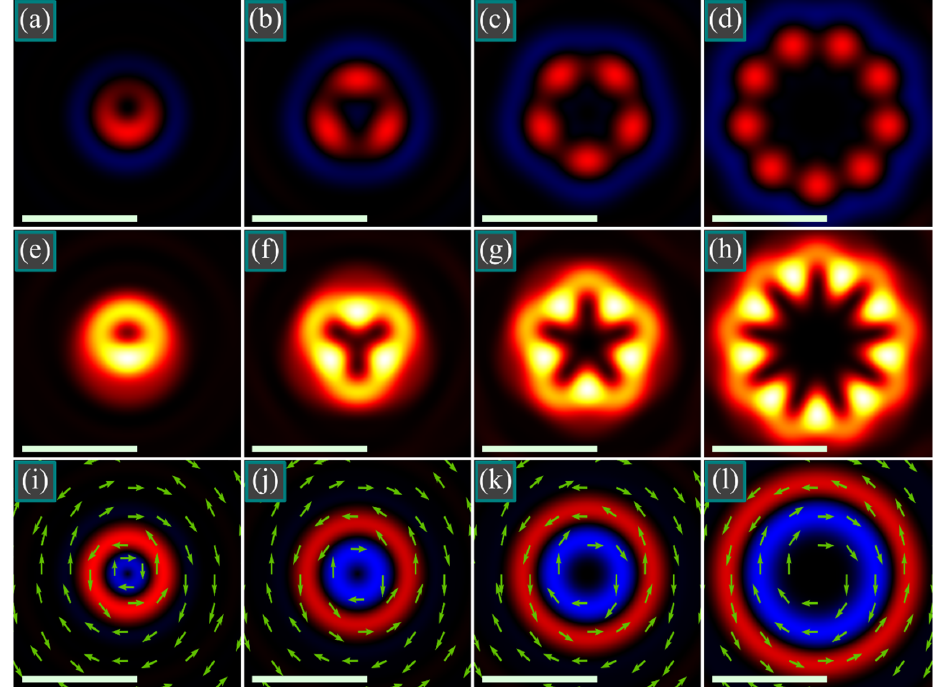
Figure 1. Distributions of the longitudinal component of the spin angular momentum ( a – d ) (red and blue color denote, respectively, positive and negative values), intensity ( e – h ) (black means zero and yellow means maximum), and the angular component of the Poynting vector ( i – l ) (red means pos ‐ itive and blue means negative values) of a light beam with polarization (3) and with a different order at the tight focus. Arrows ( i – l ) denote the directions of the angular energy flow. The scale mark in each figure denotes 1 μ m.